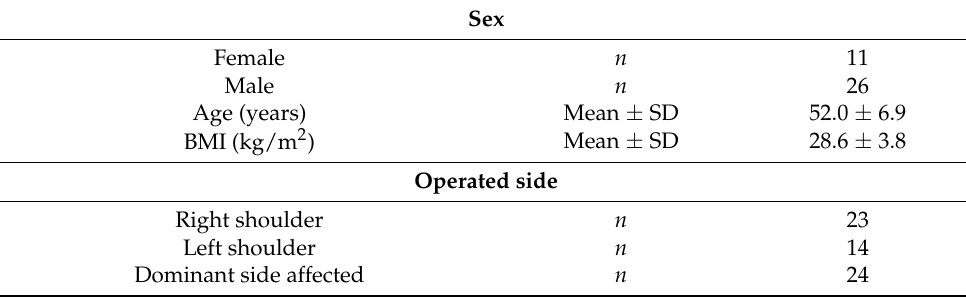
Table 1. Demographic data and baseline characteristics of study patients ( n =